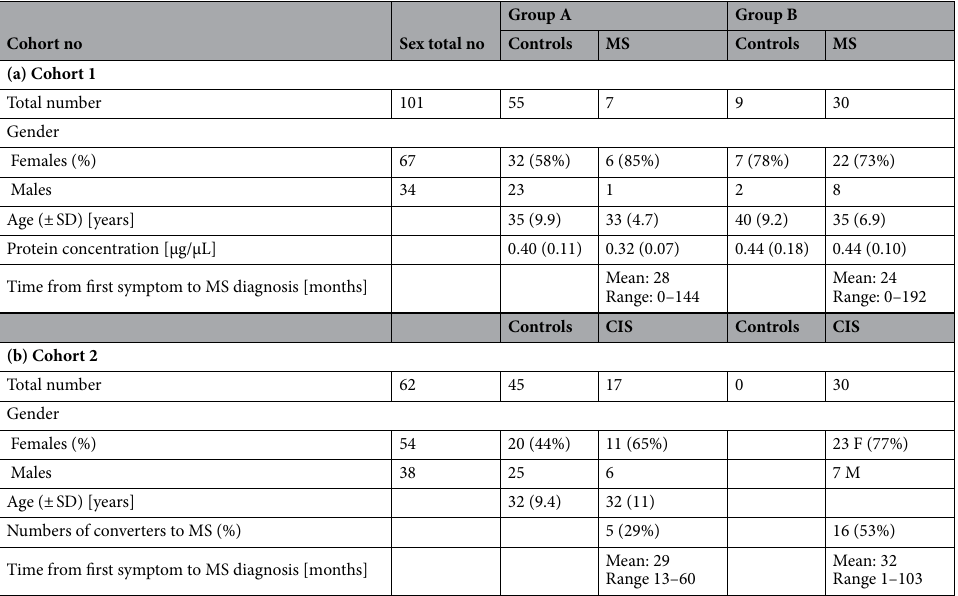
Table 1. Descriptive statistics of cohorts 1 and 2. Gender and the number of MS converters are given as numbers of individuals with percentage in brackets, and other values are given as means with standard deviations or ranges in